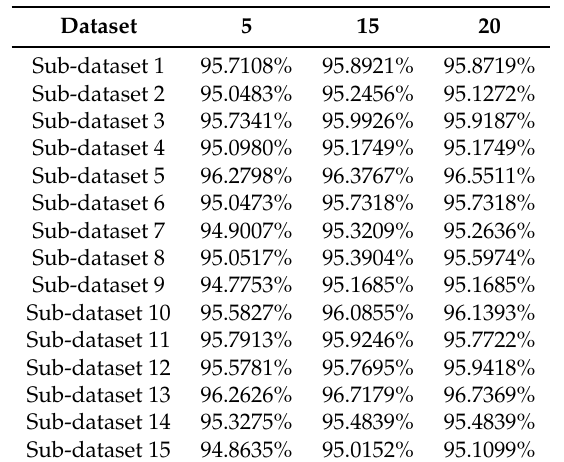
Table 5. Accuracy results of Random Subspace Learning-based K-Nearest Neighbor (RSL-KNN) under binary classification.